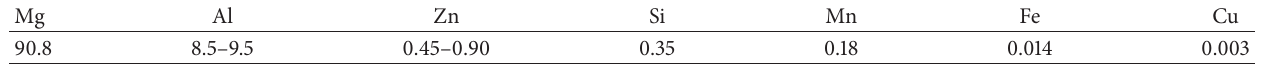
Table 1: Chemical composition of AZ91 magnesium alloy